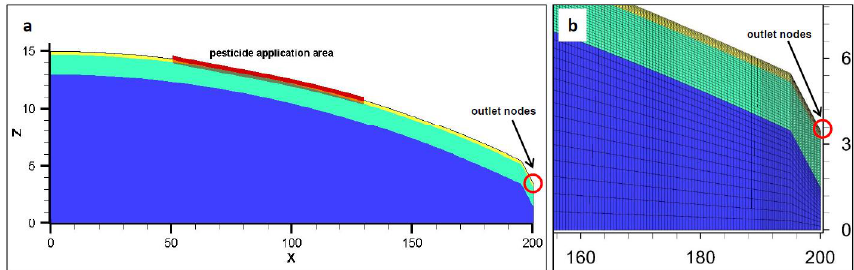
Fig. 1. Model domain with the pesticide application area (red) and three subsurface zones: topsoil (yellow), subsoil (green) and bedrock (blue) (a) . The discretization is finer in the upper soil and close to the hillslope outlet (b) . The hillslope outlet is represented by two boundary nodes (red